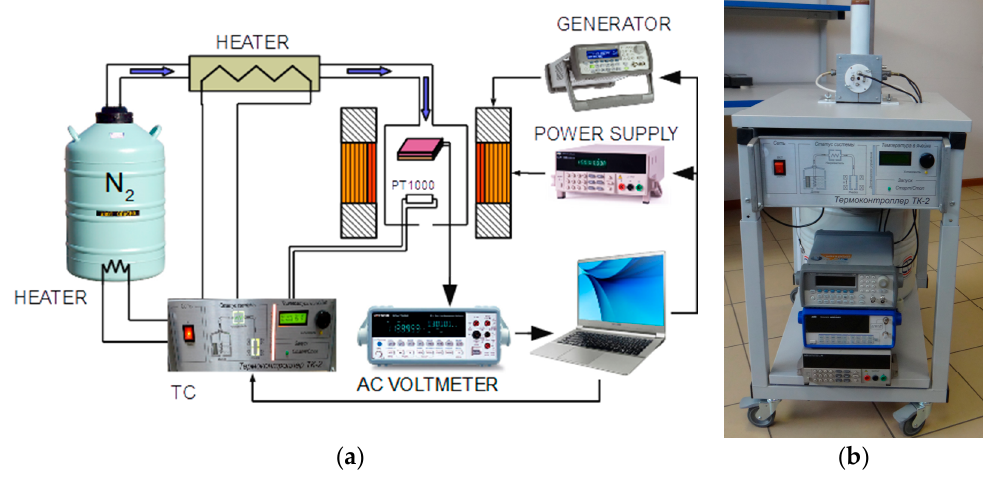
Figure 1. Block diagram of the apparatus for the investigation of temperature characteristics of the magnetoelectric (ME) effect in composite structures ( a ) and its appearance ( b ). TC denotes the temperature controller.